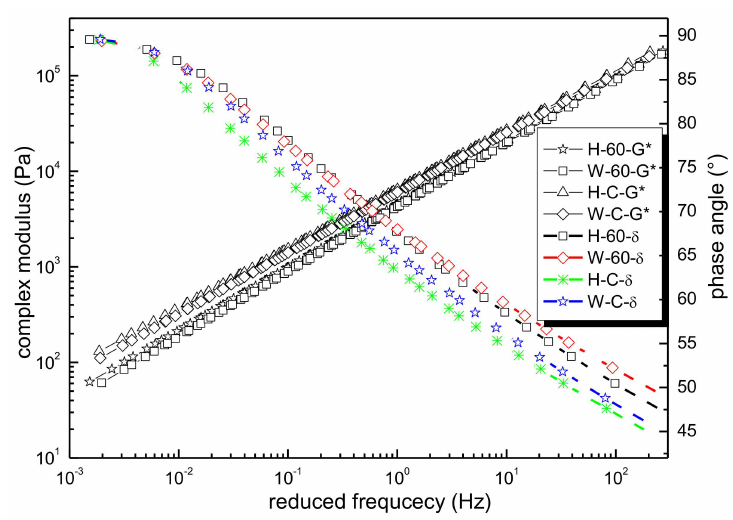
Figure A1. The master curve of complex modulus and phase angle for